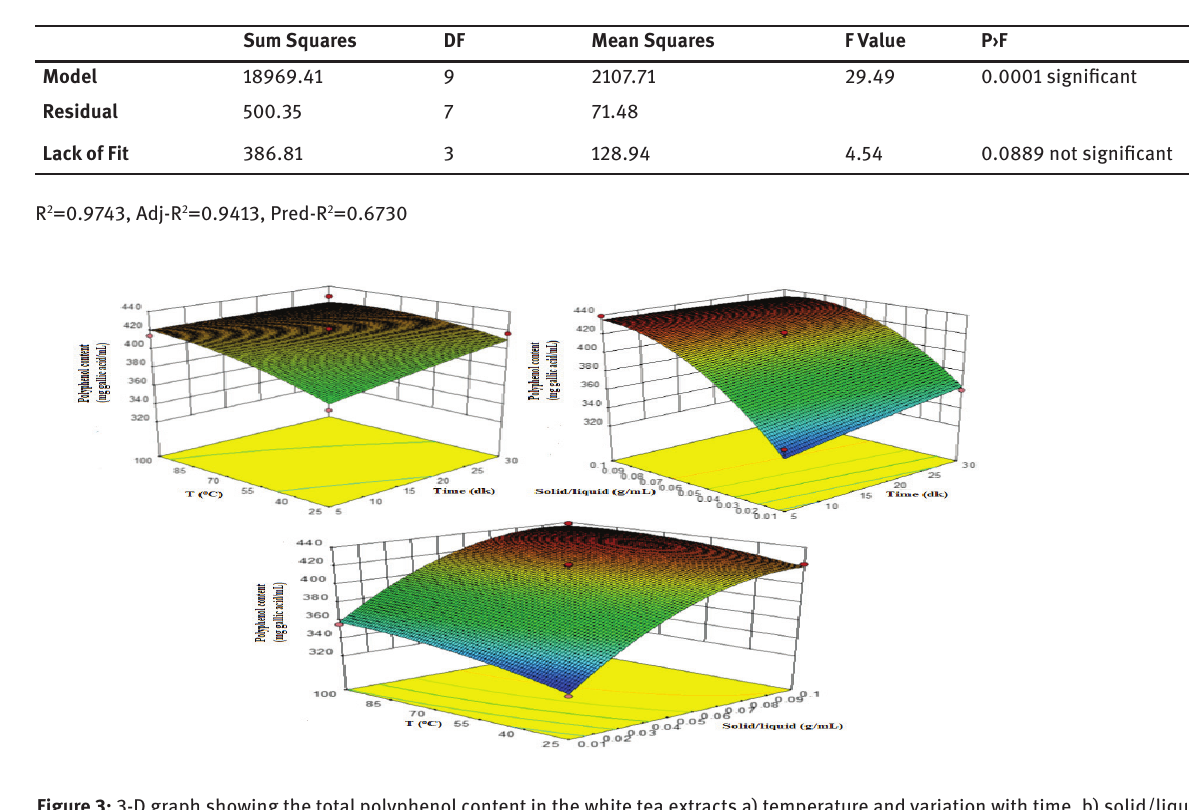
Figure 3: 3-D graph showing the total polyphenol content in the white tea extracts a) temperature and variation with time, b) solid/liquid ratio and variation with time, c) temperature and variation with solid/liquid